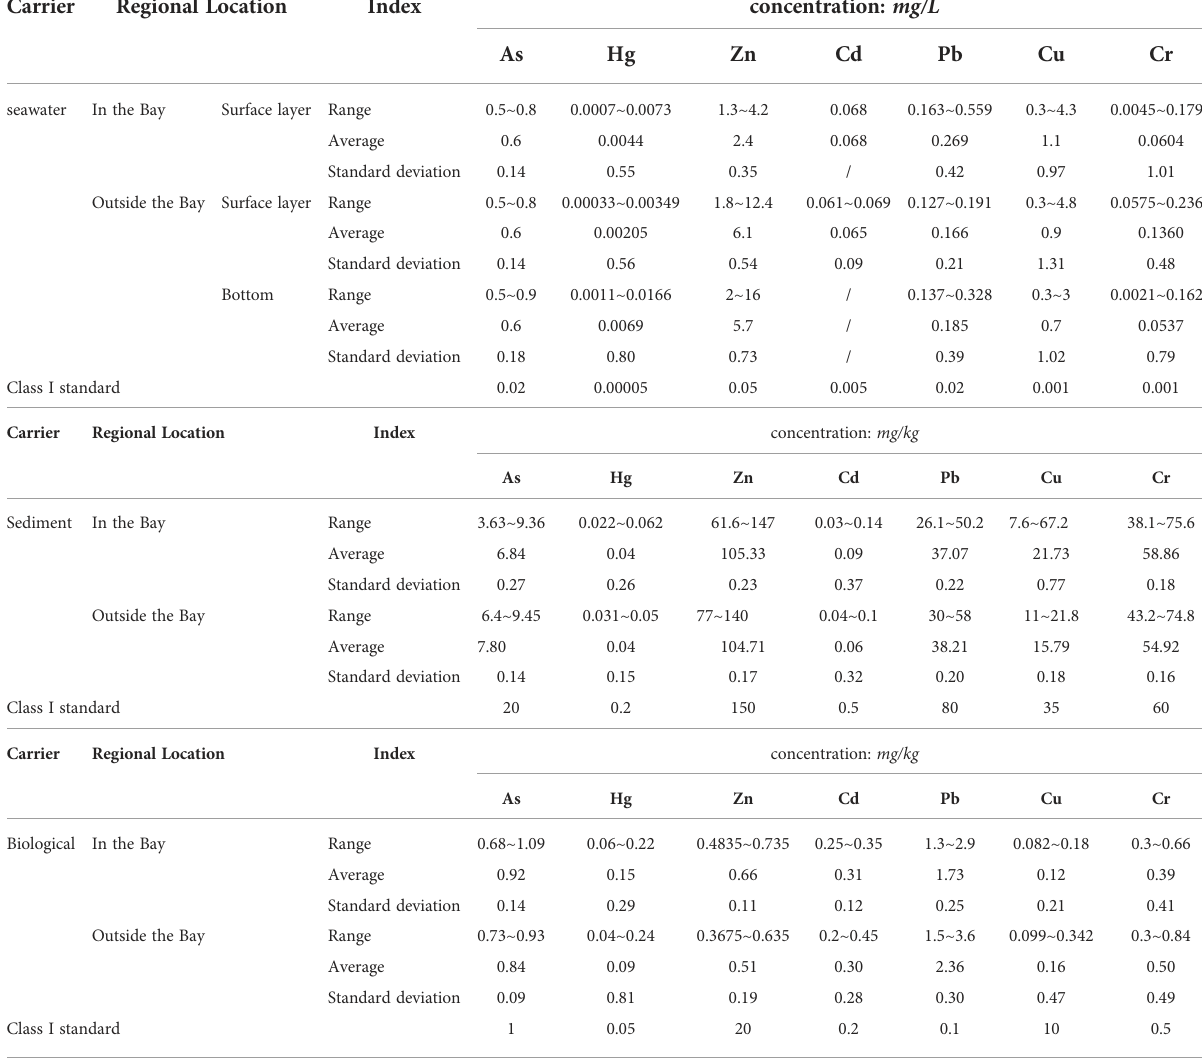
TABLE 3 Evaluation results of heavy metal quality indices in the sea area.